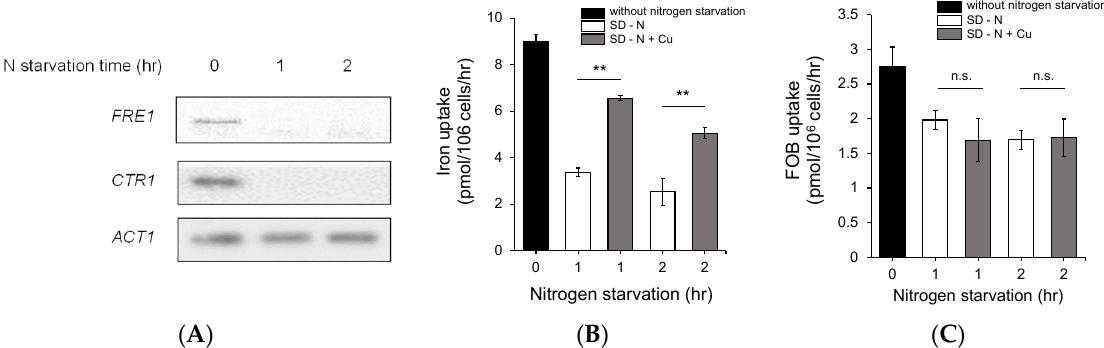
Figure 3 . Nitrogen starvation downregulated the expression of the genes involved in copper metabolism. ( A ) Expression of the genes involved in copper uptake was investigated to determine whether gene expression is regulated by nitrogen starvation. The wild-type cells were cultured and starved of nitrogen as described in the Materials and Methods section, and total RNA was extracted. ACT1 was used as a loading control. ( B ) The effect of copper on iron uptake under nitrogen starvation conditions was investigated. The wild-type cells were starved of nitrogen with (white column) or without (gray column) copper, and then, an iron uptake assay was performed. ( C ) A ferrioxamine B (FOB) uptake assay was performed to identify the effect of copper on FOB uptake. Desferol and Fe 55 were mixed at equal concentrations prior to the uptake assay, and then, the uptake assay was performed as described for the free iron uptake assay. n.s., not significant; **: p < 0.01 indicates a significant difference compared to other groups.